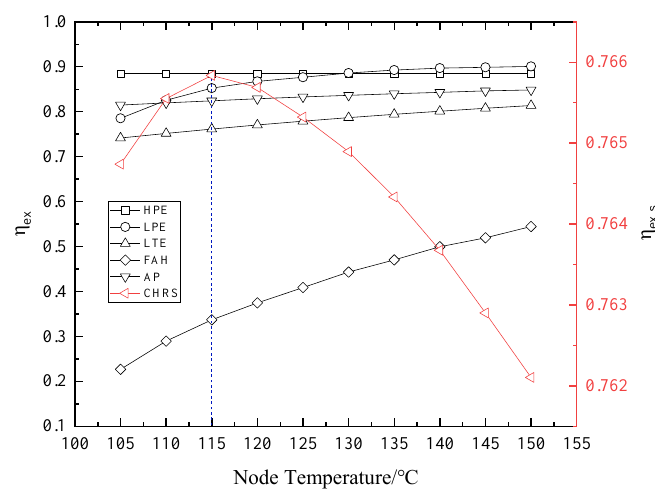
Figure 4. Exergy efficiency of heat exchangers and CWHRS at different node temperatures. Figure 4. Exergy e ffi ciency of heat exchangers and CWHRS at di ff erent node temperatures. The EBCs of the CWHRS at different node temperatures are calculated using Equation (36).